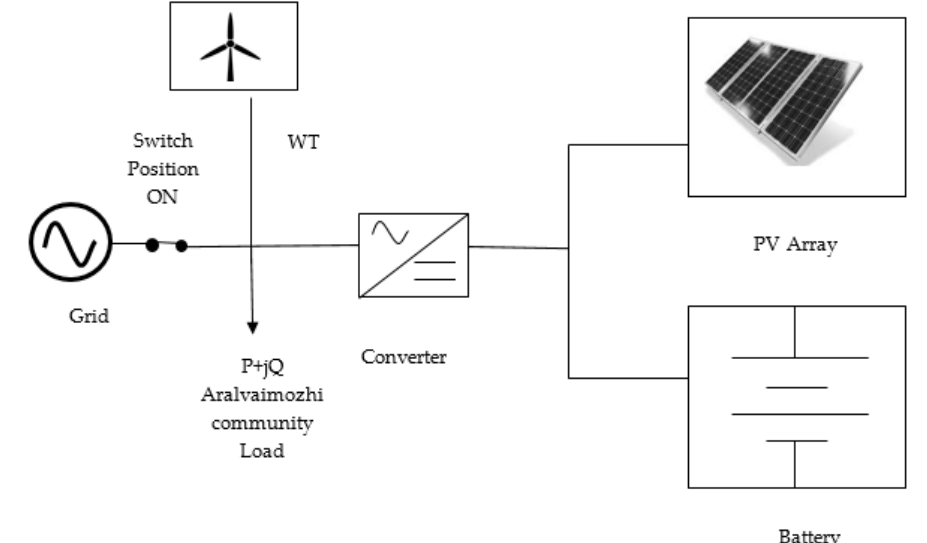
Figure 7. The HRES for Aralvaimozhi community, India.